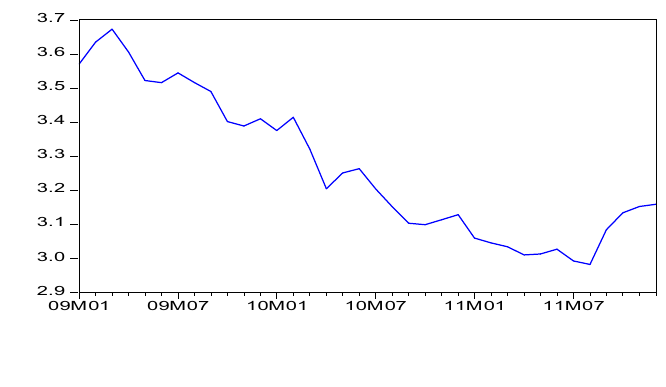
Figure 3: Real Exhange Rate in Malaysia from January, 2009 to December,